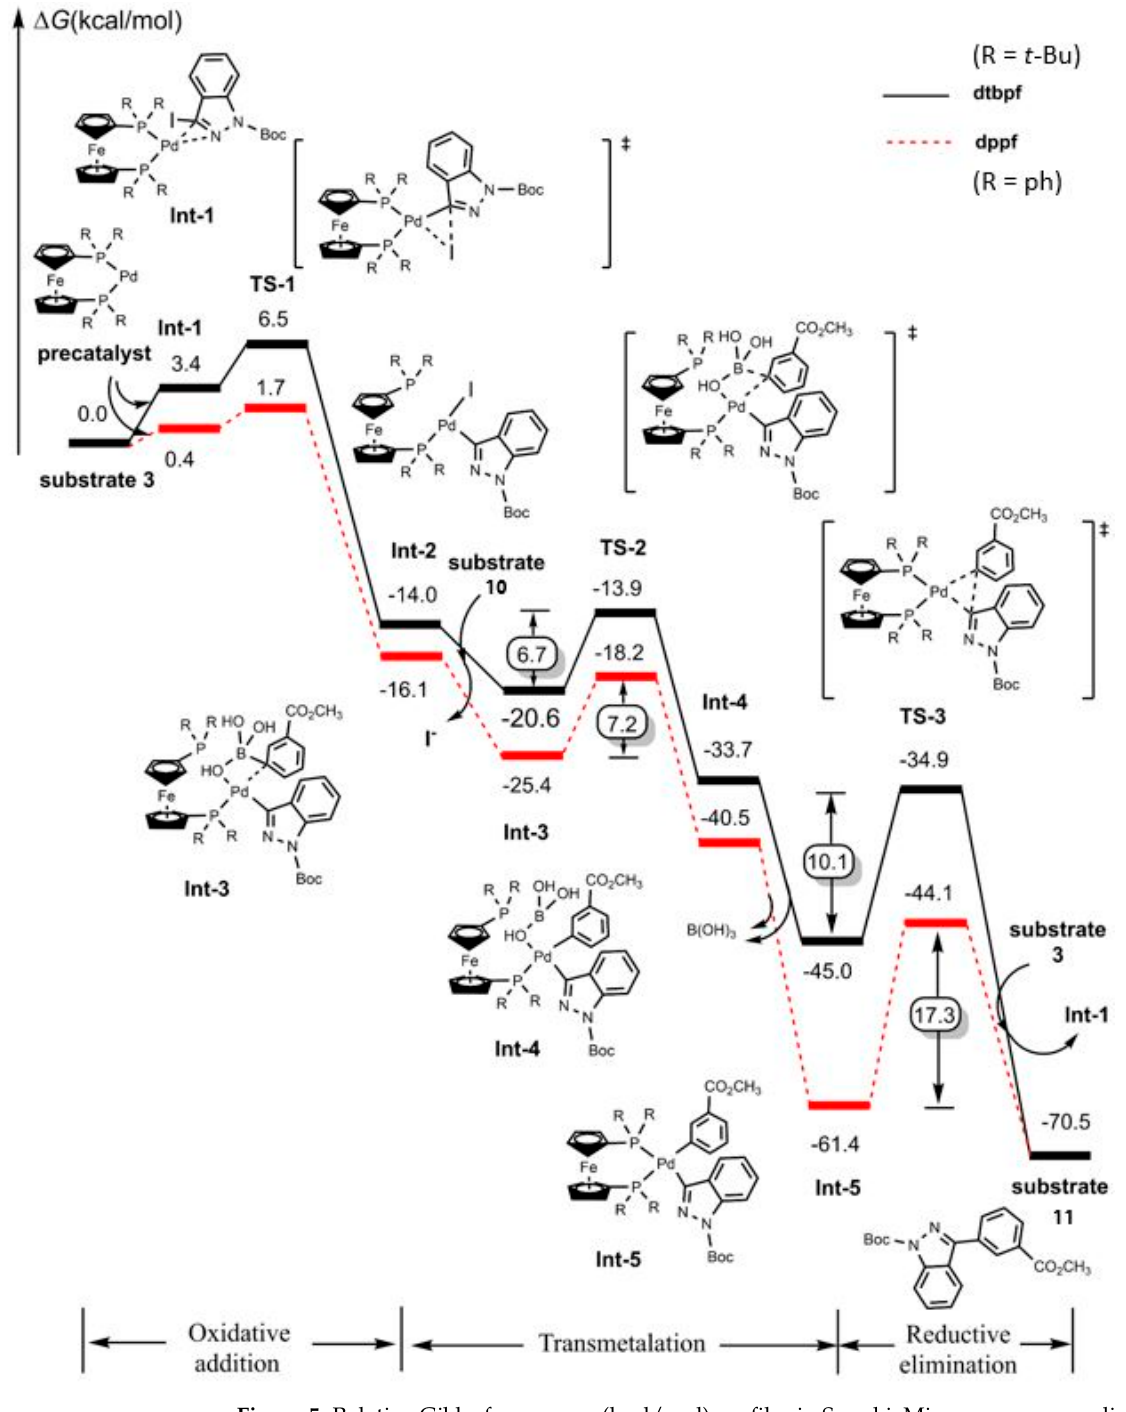
Figure 5. Relative Gibbs free energy (kcal/mol) profiles in Suzuki–Miyaura cross-coupling of com- pounds 3 with 10 to yield compound 11 using Pa catalyst featuring dtbpf (balck solid line) or dppf (red dashed line) ligands.